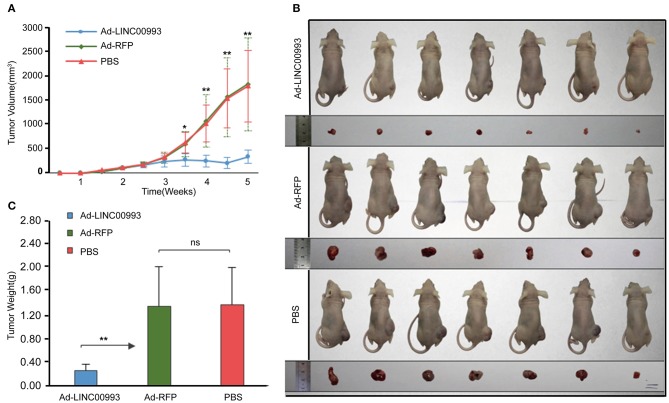
LINC00993 suppresses the growth of triple-negative breast cancer (TNBC) in vivo. (A) The average tumor volume in Ad-LINC00993 group was much smaller than that in Ad-RFP or PBS group. (B) Image of nude mouse burden with breast cancer. Five weeks after cell injection, the mice were sacrificed, and the weight of tumors were examined. (C) The average weight of Ad-LINC00993-treated tumors was markedly lower than control. *P < 0.05 and **P < 0.01 based on Student's t-test. Data were presented as mean ± SEM.